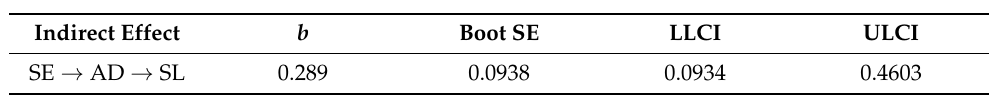
Table 4. Index of indirect